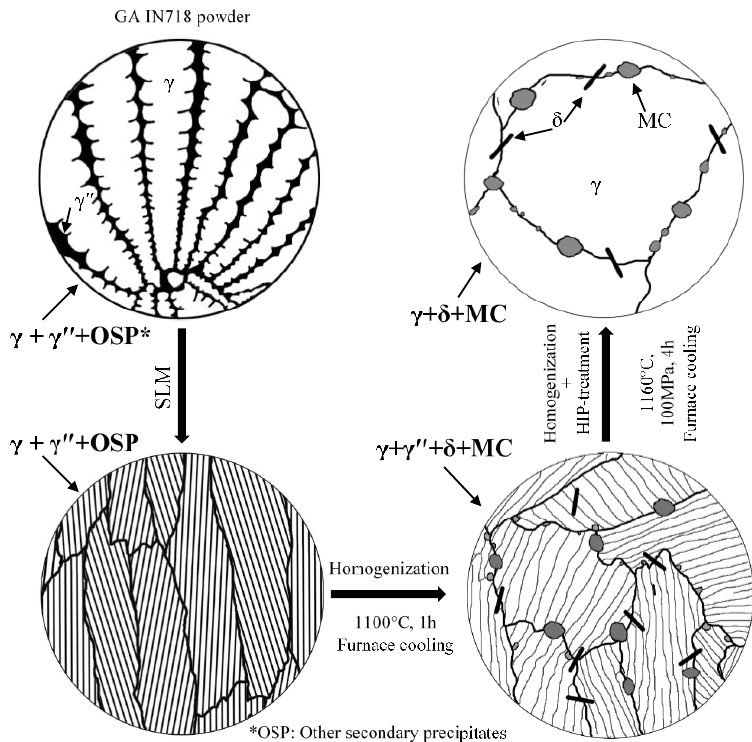
Figure 19. Schematic illustration of the microstructural changes and phase evolution in the gas atomized, 3D printed by SLM and heat treated IN718 superalloy.